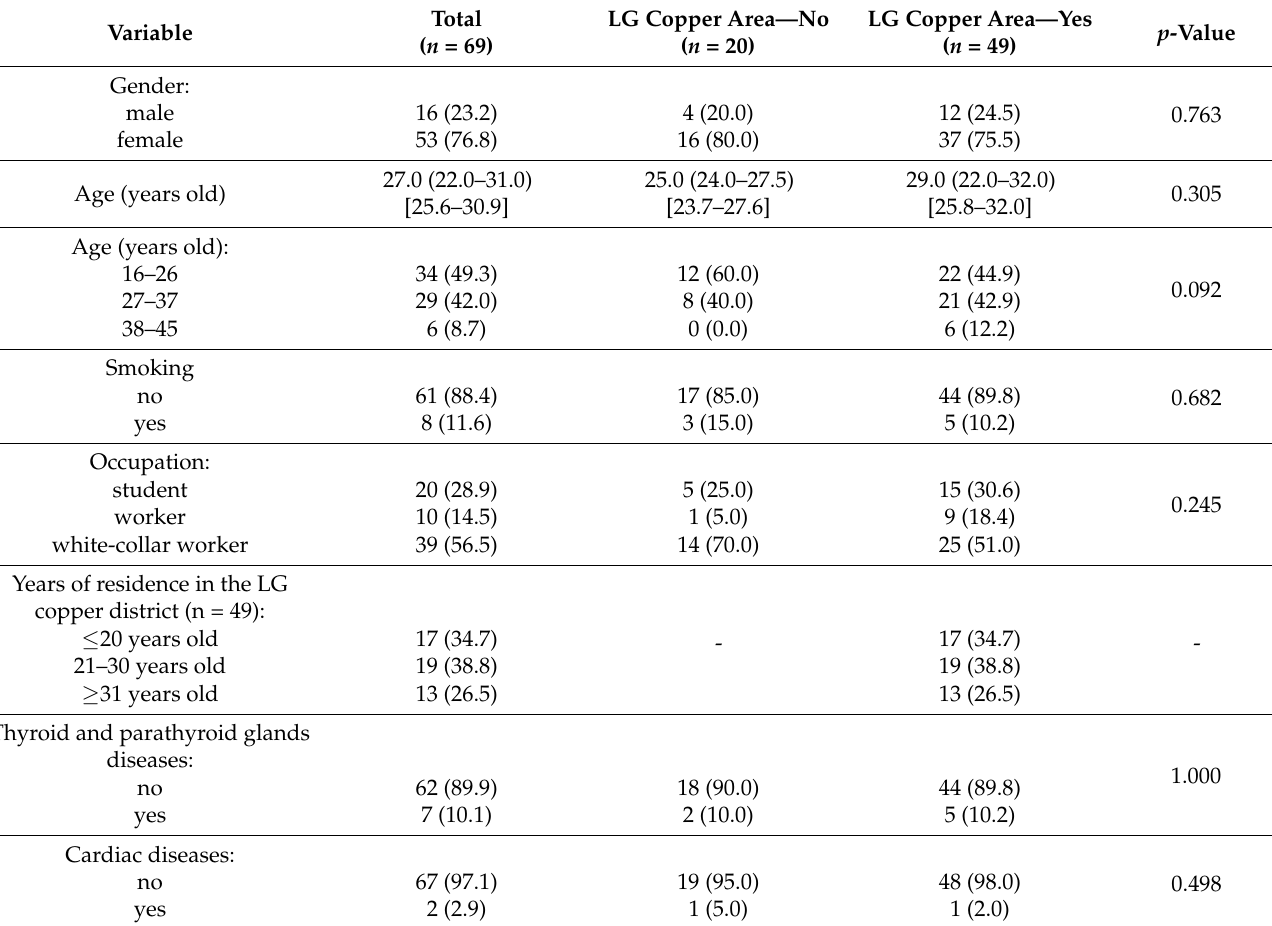
Table 2. Demographical, clinical, and laboratory characteristic of total study group and two subgroups of patients, divided according to place of residence. Descriptive data were presented as